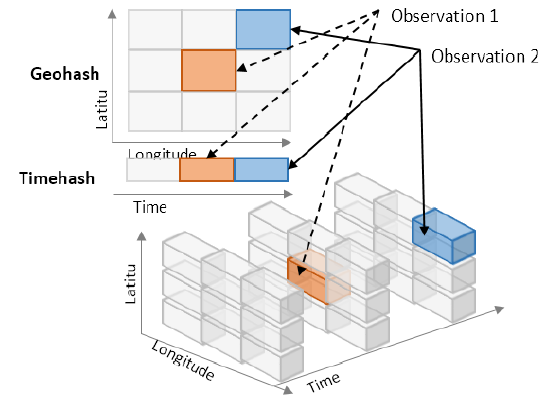
Figure 3. Concatenation of Geohashing